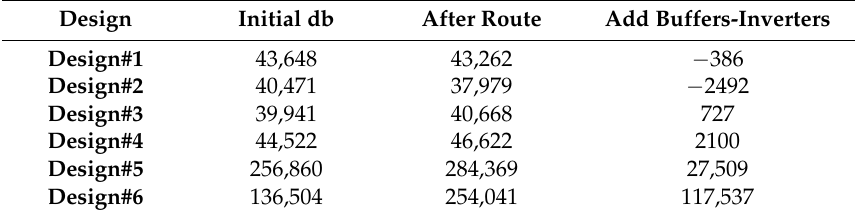
Table 7. Buffer–inverter cell count in the initial database and in the routed database.